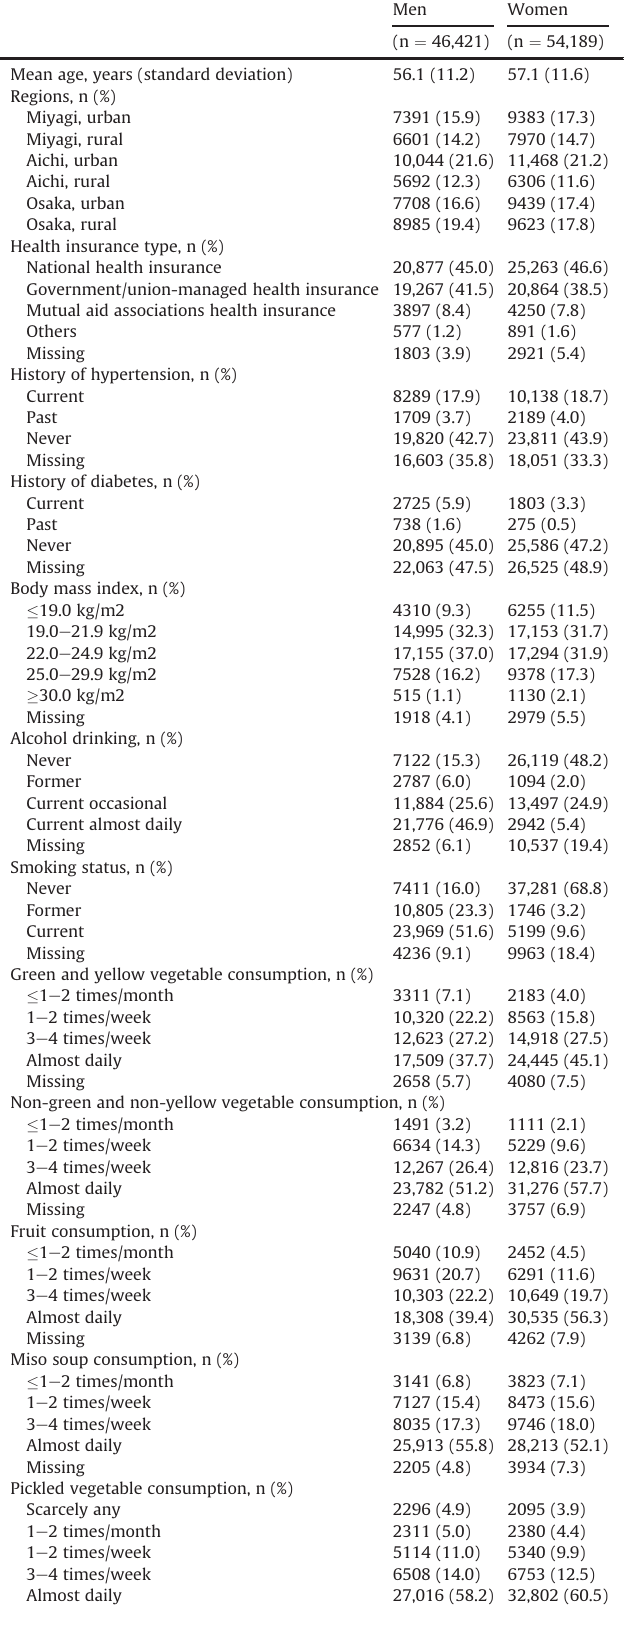
Table 3 Selected baseline demographic and lifestyle characteristics of participants by